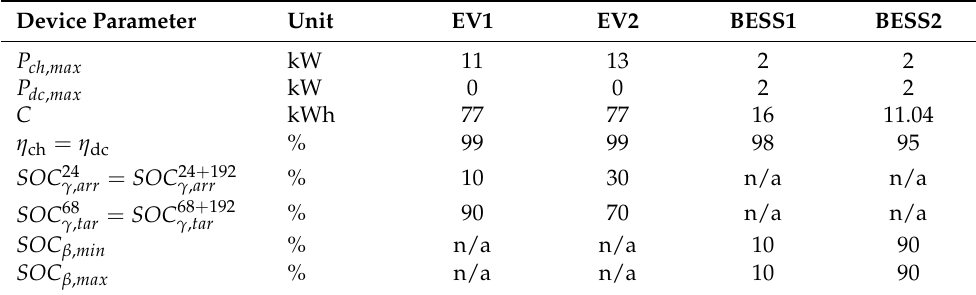
Table 1. Device parameters of EVs and BESSs in an exemplary production facility, which were used for the model composition in the system